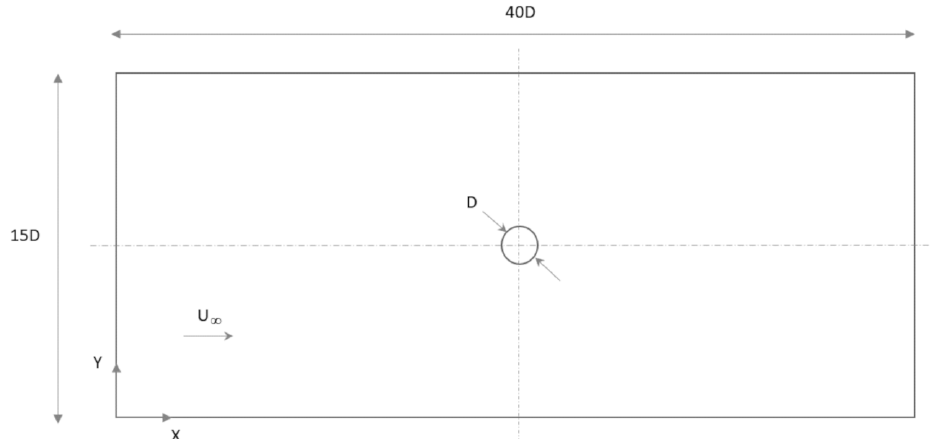
Figure 1. Problem setup and arrangement for the cylinder in the channel.